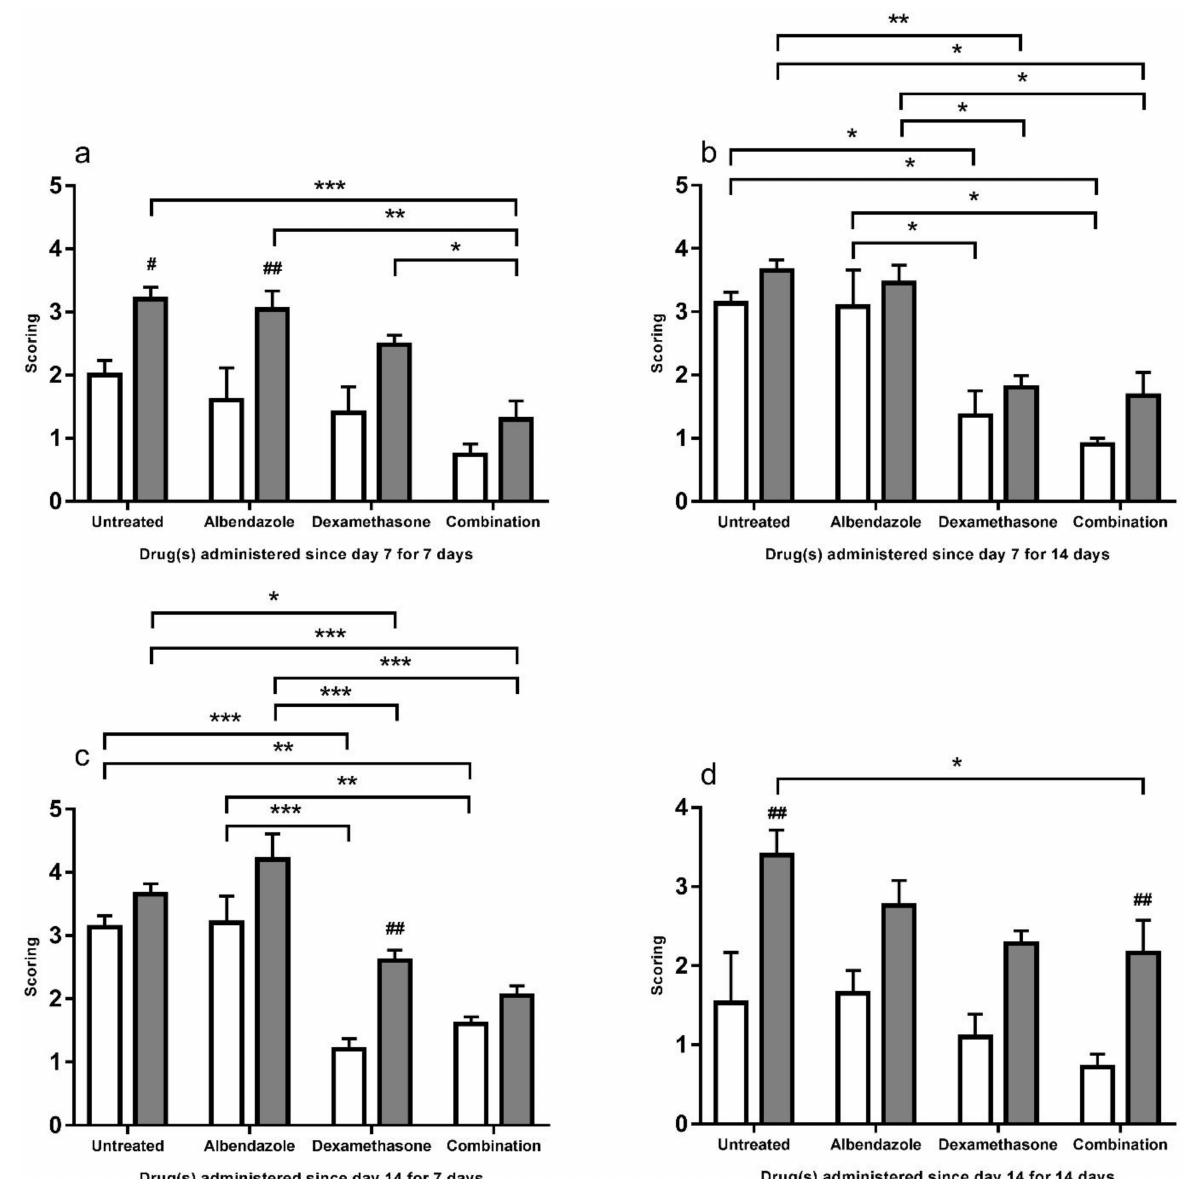
Figure 9. Scorings of brain necrosis and choriomeningitis in the cerebral parenchyma of the BALB/c (white) and C57BL/6 (gray) untreated mice and those treated with albendazole alone dexamethasone alone, and co-therapy of the two drugs after infection with Angiostrongylus cantonensis . Data are expressed as mean ± standard error of the mean (untreated group vs. albendazole group vs. dexamethasone group vs. co-therapy group, * p < 0.05, ** p < 0.01, *** p < 0.001) (BALB/c mice vs. C57BL/6 mice, # p < 0.05, ## p <